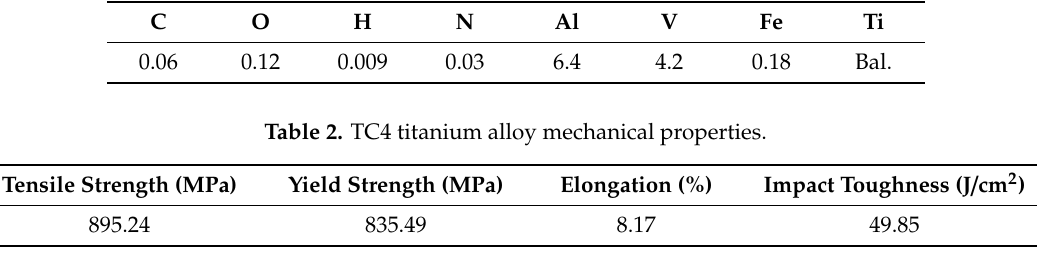
Table 1. TC4 titanium alloy chemical component (mass fraction/%).